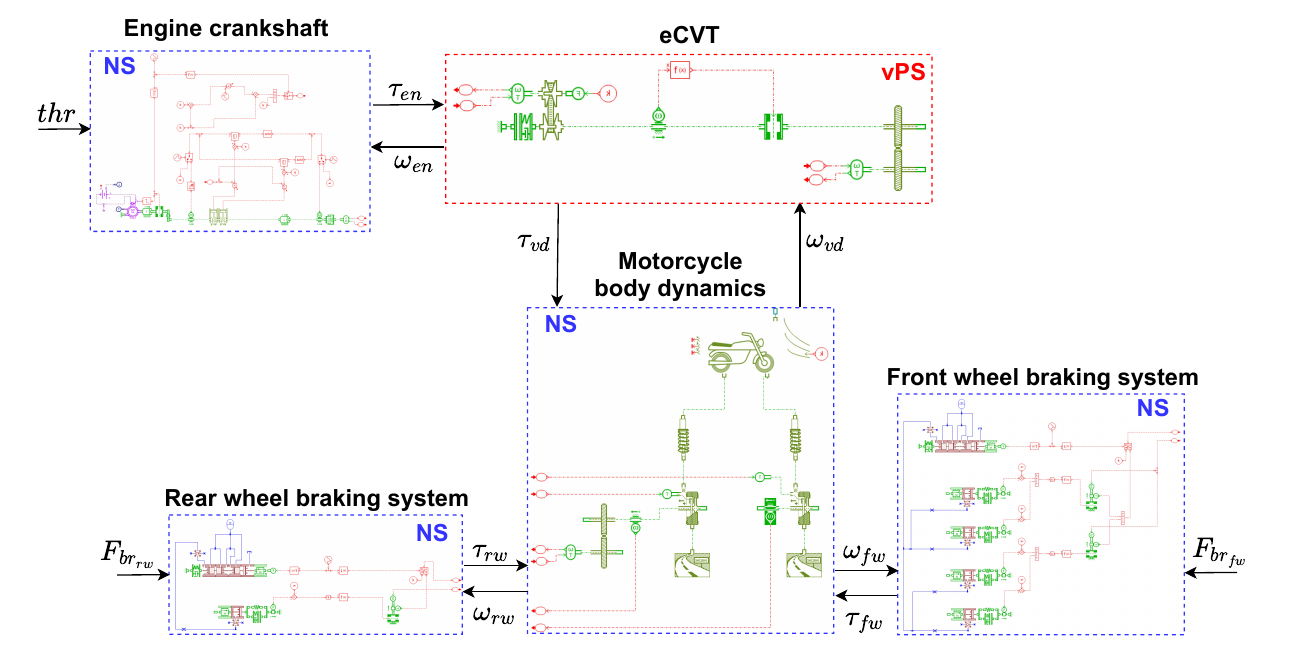
Figure 1. Motorcycle hybrid model block